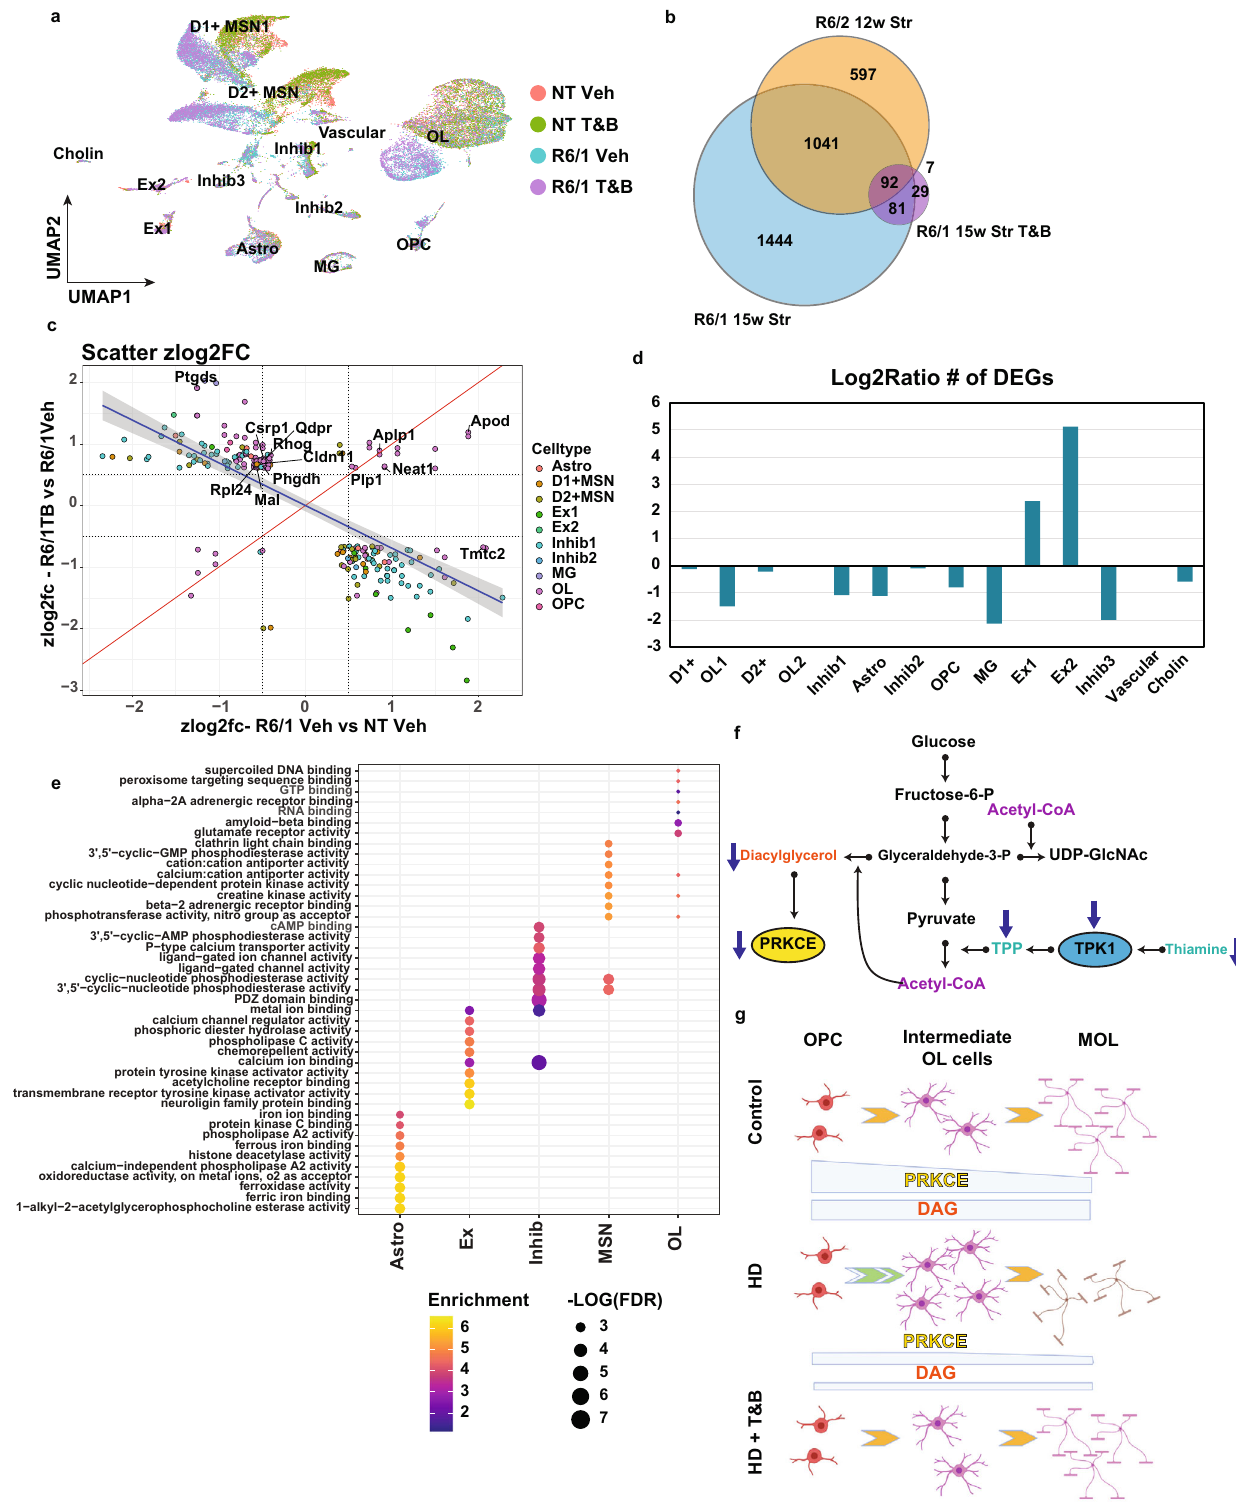
Fig. 8 | Thiamine and biotin study in R6/1 mice shows rescue ofOL maturation DEGs and other cell type DEGs. a UMAP showing the R6/1 and NT mouse data colored bygenotype and treatment. b Venn diagram comparing genotypeDEGs in 15w R6/1 mice and 12wStr of R6/2 mice against each other and treatment effect DEGsfromR6/1T&Btreatedversusvehicle. c ScatterplotshowingZ-scorelog2FCof allgenesoverlappingbetweengenotypeandtreatmenteffectDEGs.Coloredbycell typeorigin.OLandInhib1neuronsshowthemostrescuedDEGs.Quadrants1and3 represent rescue of expression and 2 and 4 represent exacerbation. d Barplot